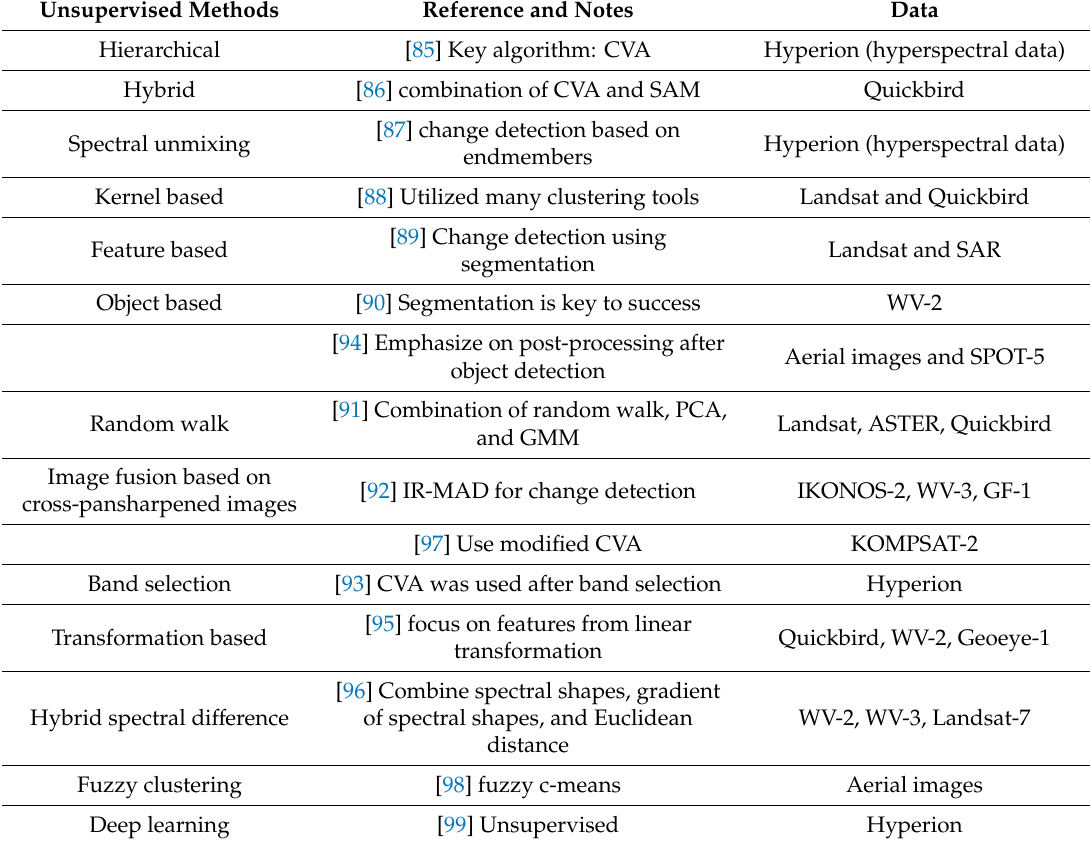
Table 2. Summary of recent unsupervised change detection